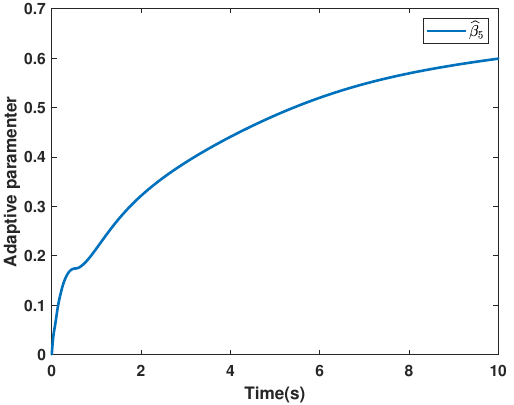
Figure 13. Adaptive parameter (cid:98) β 5 ( t )